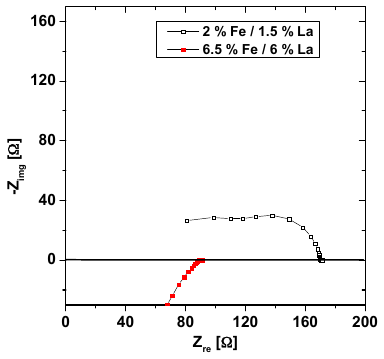
Figure 12. Impedance spectra of PZT with 2% Fe/1.5% La and 6.5% Fe/6% La, measured in ambient air at 560 °C.